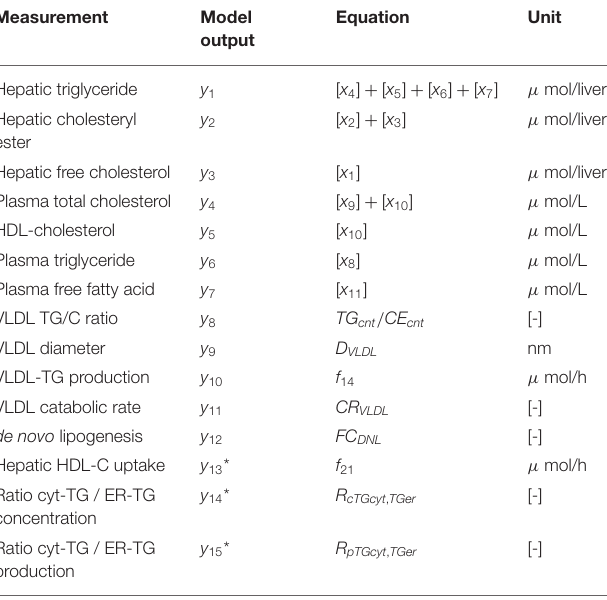
TABLE 2 | Measured quantities and their relation to model